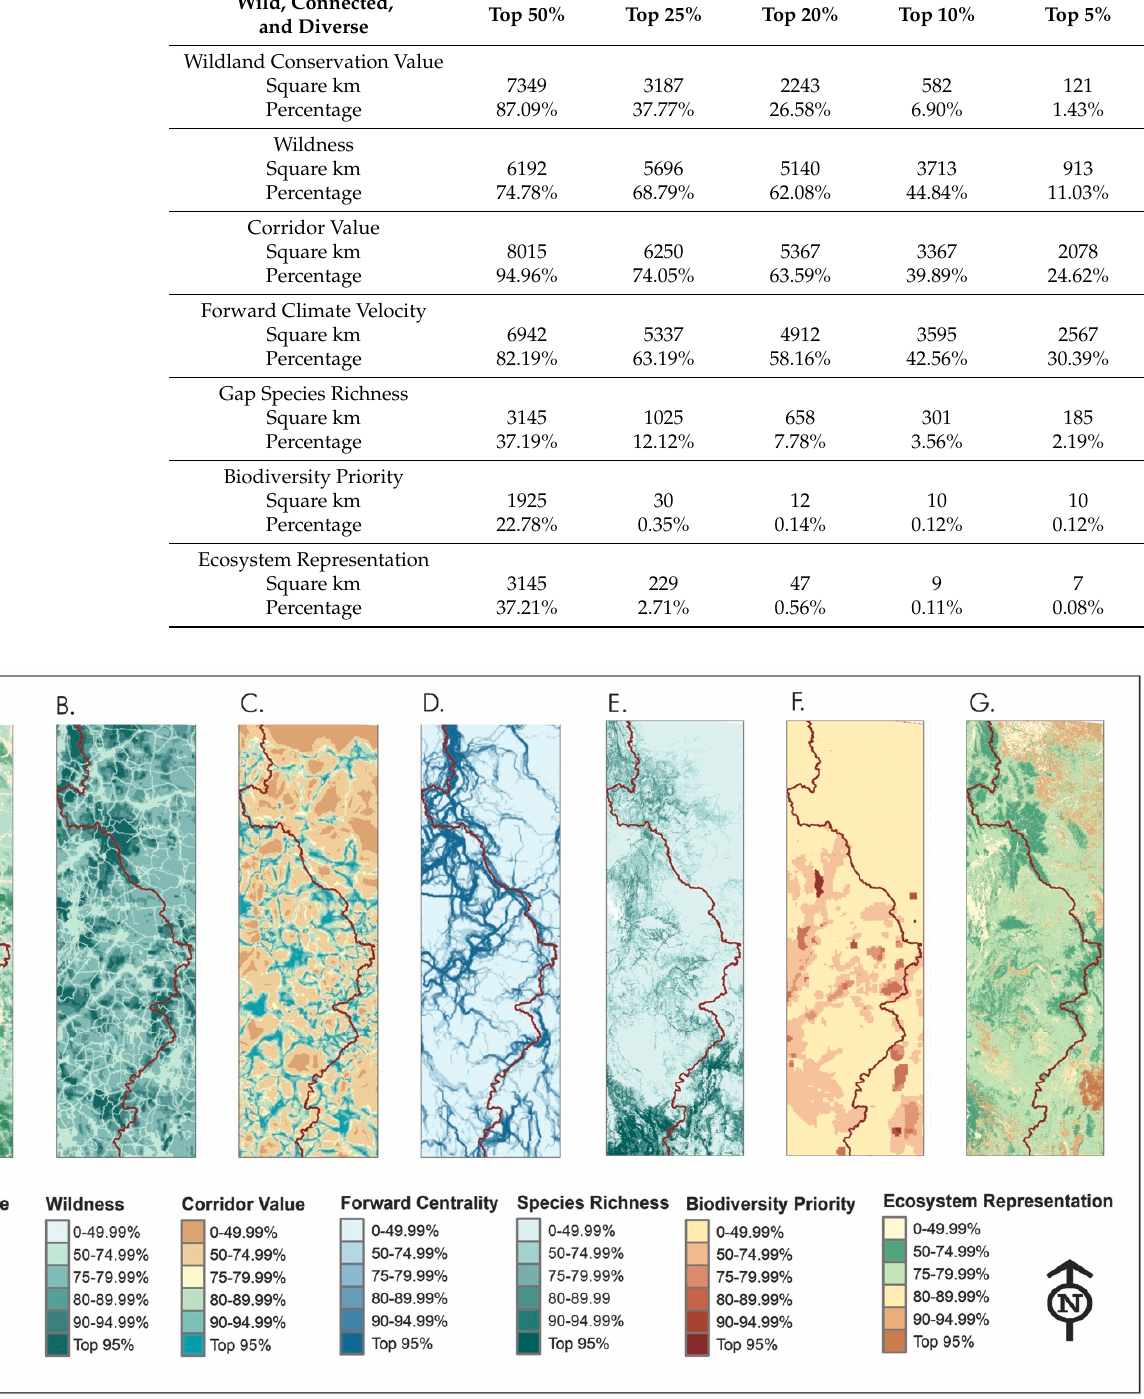
Table 3. The conservation values of the Continental Divide Trail corridor.